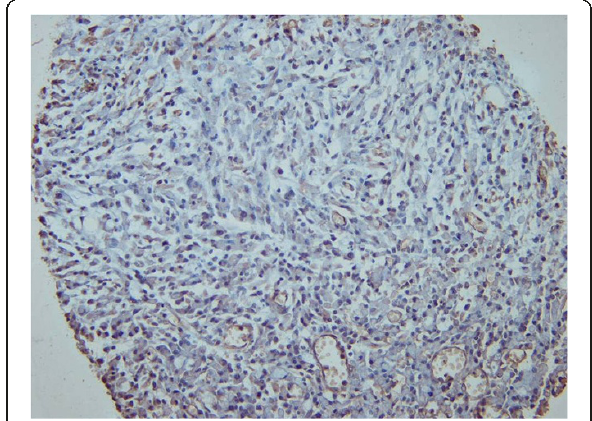
Figure 1 Immunohistochemical staining using c-MET antibody showing weak (+1) cytoplasmic reaction in gastric cancer cells (c-MET, x200).